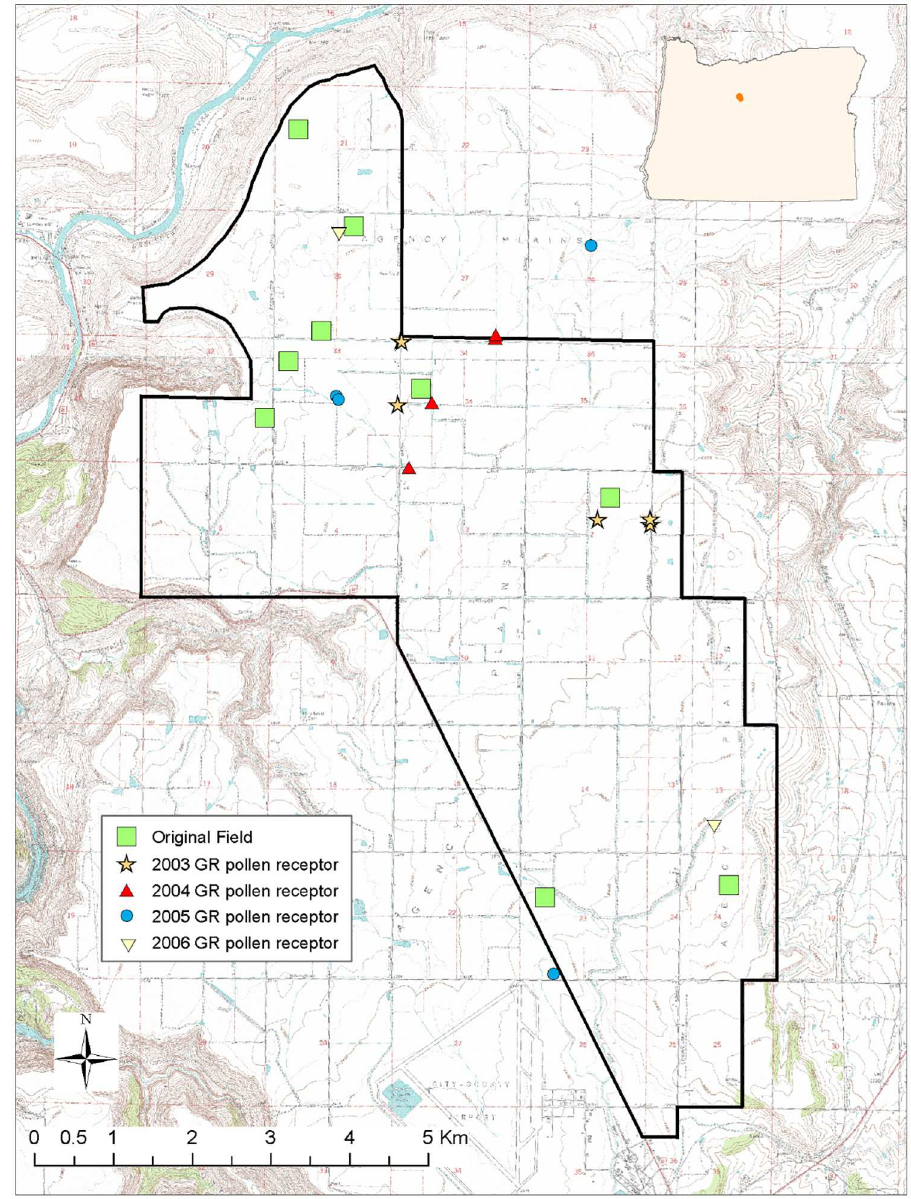
Fig 2. Location of susceptible plants that produced transgenic Glyphosate-Resistant(GR) seedlings (GR pollen receptor) in the four years. The black line is the limit of the transgenicglyphosateresistant creeping bentgrass (GRCB) seed production control area. Green squaresrepresent the locationof the originalGRCB fields established in 2002 and removedafter seed harvest in 2003. Stars, triangles, circles and invertedtrianglesrepresent the locationof GR pollenreceptor plants for 2003, 2004, 2005 and 2006, respectively. A single point may represent more than one plant. The inserted map shows the locationof the control area in relationto the state of Oregon,